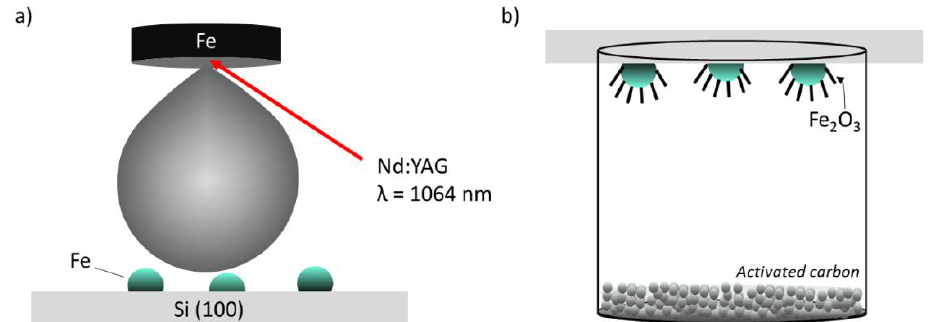
Figure 1. Schematic diagram of iron oxide nanostructure synthesis. The fabrication steps consist of two parts, namely ( a ) laser ablation of the Fe metal target using the Q-switch Nd:YAG pulsed laser operating at the fundamental harmonic, λ = 1064 nm. The Fe microspheres formed in the vicinity of unheated Si(100); ( b ) carbothermal oxidation of Fe microspheres at high temperatures (up to 800 °C) with activated carbon powder for 2 h. Iron oxide nanostructures grew radially outward from iron microspheres.